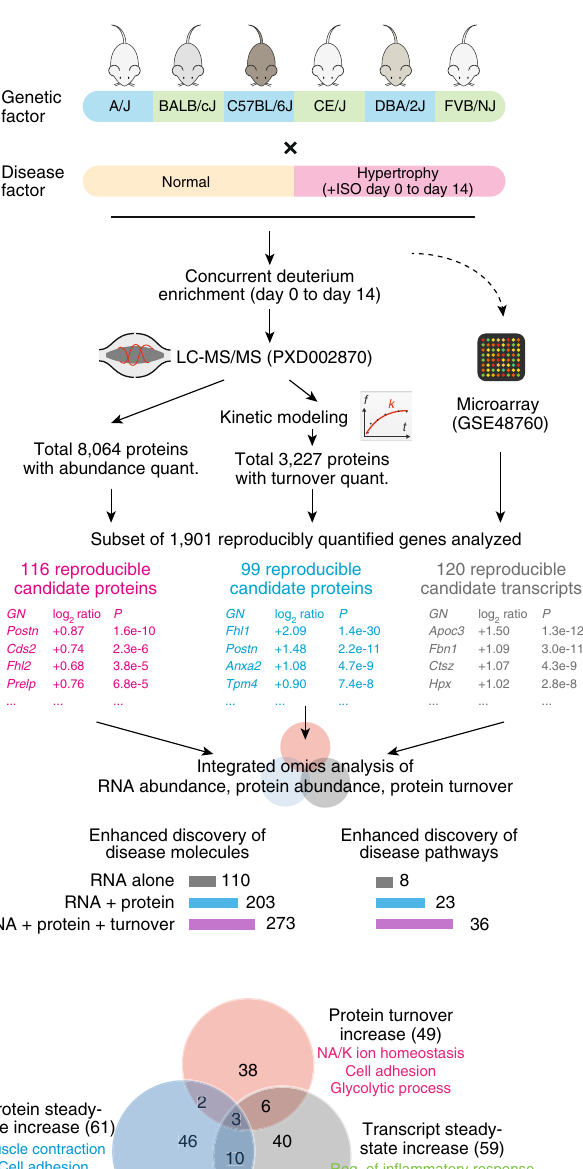
Metabolic process Fatty acid beta-oxidation Neg. reg. of endopeptidases Fatty acid metabolic processes Protein stabilization Protein ubiquitination Fig. 1 Signatures of cardiac hypertrophy at transcript, protein, and turnover levels. a Schematic of multi-omics analysis. b Plot of log ratios of protein turnover in hypertrophic vs. normal hearts ( x -axis) against log ratios of protein abundance ( y -axis) across six mouse strains ( n = 5593 data points). Changes in protein turnover are poorly correlated with changes in protein abundance, accounting for only 11% of variations in protein abundance. Blue line: linear regression; rug: data density; rho: Spearman ’ s correlation coef fi cient. c Plot of log ratios of protein turnover in hypertrophic vs. normal hearts ( x -axis) against log ratios transcript abundance ratio (y -axis) (NCBI GEO GSE48760) ( n = 5601 data points). Changes in protein turnover are minimally correlated with changes in transcript abundance, accounting for only 9% of variations in protein abundance. Blue line: linear regression; rug: data density; rho: Spearman ’ s correlation coef fi cient. Steady-state and turnover changes to isoproterenol are largely orthogonal. d Venn diagram of consistently implicated candidate disease signatures identi fi ed at the transcript, protein and protein turnover levels. Candidate disease markers are de fi ned as having shown increases (left) or decreases (right) at 80th percentile or above in ≥ 4 mouse strain. Enriched Gene Ontology (GO) biological processes in genes with differential protein turnover, protein steady-state abundance are also